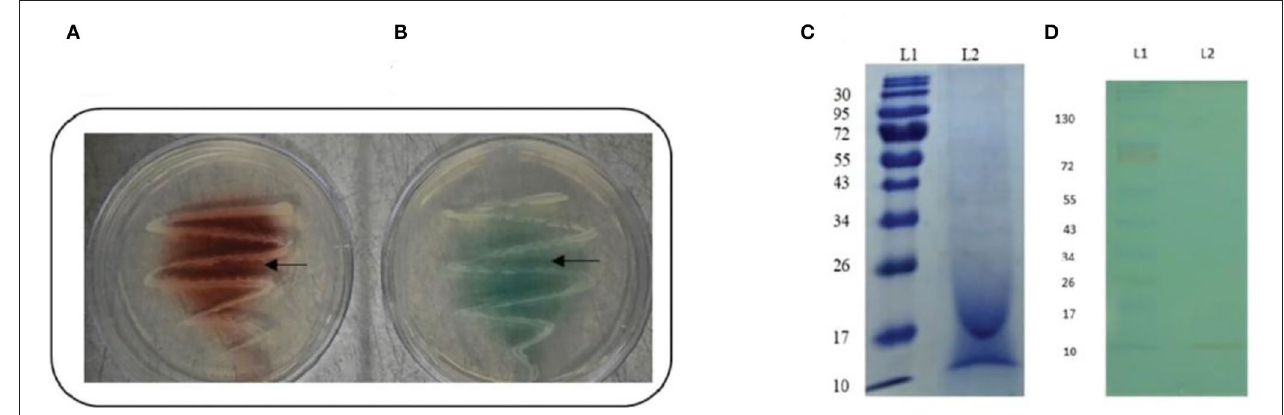
FIGURE 1 | Confirmation of laccase production by strain AORB19. (A) Guaiacol plate assay showing reddish brown oxidation zone around bacterial colony; and (B) ABTS plate assay showing green oxidation zone around bacterial colony. (C) SDS-PAGE analyses of culture supernatant of strain AORB19. L1: Molecular mass marker, L2: Culture supernatant; (D) NATIVE - PAGE analyses of culture supernatant of strain AORB19. L1: Molecular mass marker, L2: Laccase activity staining of culture supernatant with ABTS as substrate (green